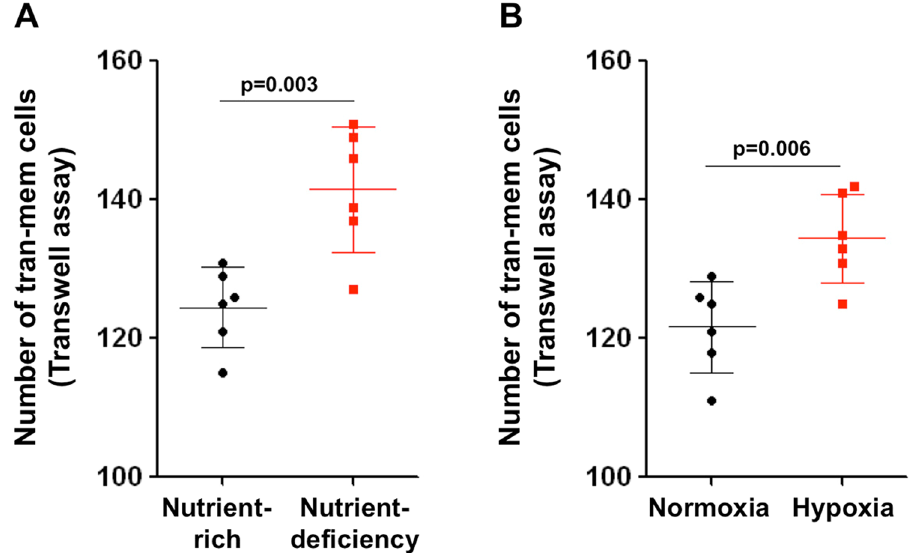
Figure 5. The nutrient-deficiency and hypoxia promoted the invasion ability of tumor cells. ( A ) The tumor cells were seeded on the upper chamber of the transwell system, and cultured in full medium or serum-free medium (to mimic nutrient deficiency). The lower chamber was filled with full medium, making sure that the solution touches the bottom surface of the upper chamber; ( B ) The transwell assay was performed in normoxia or hypoxia (1% O 2 ) incubator. The number of cells that invade into the lower chamber was counted after incubation for 24 h (n =